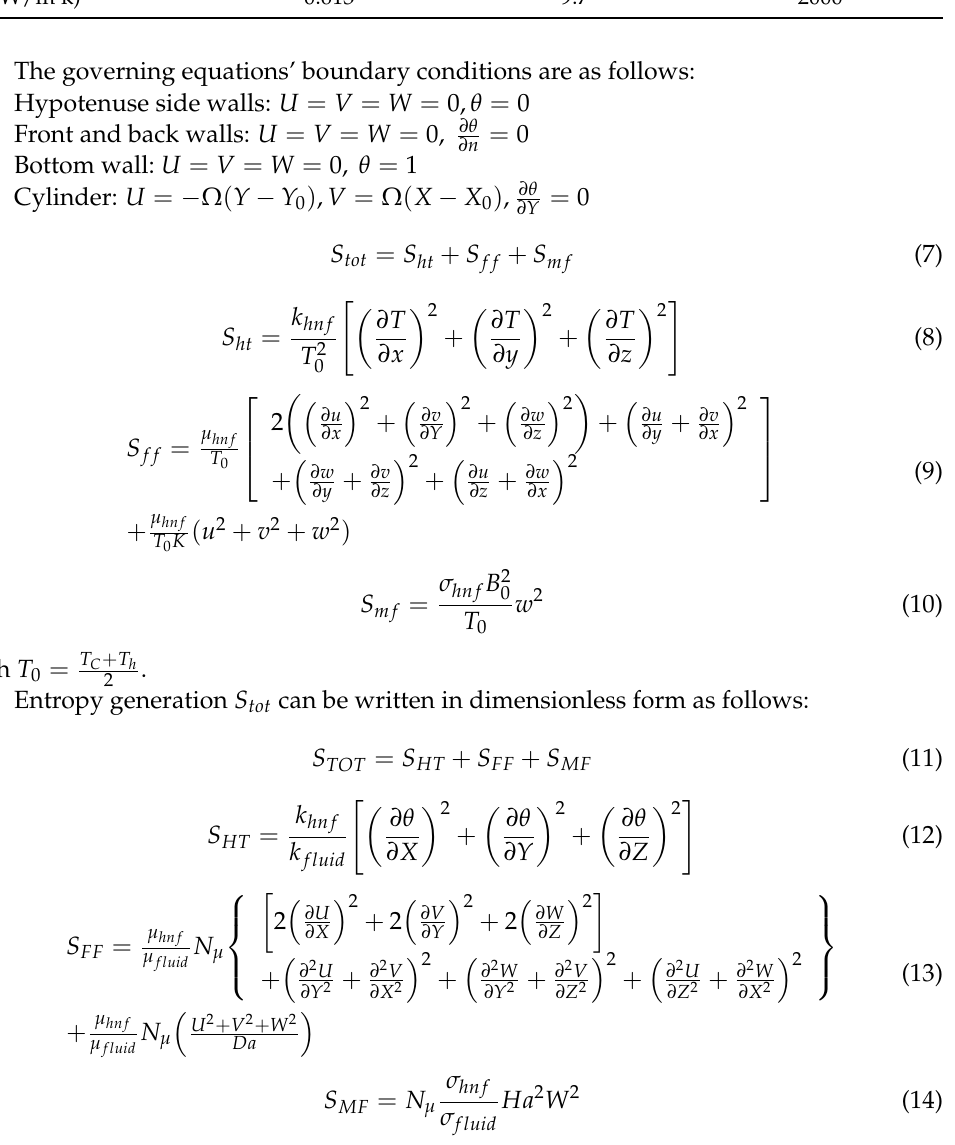
Table 1. Nanoparticles and base fluid thermos-physical properties [45]. Pure Water Fe 3 O 4 MWCNT ρ (kg/m 3 ) 997.1 5180 2100 4179 670 710 0.613 9.7